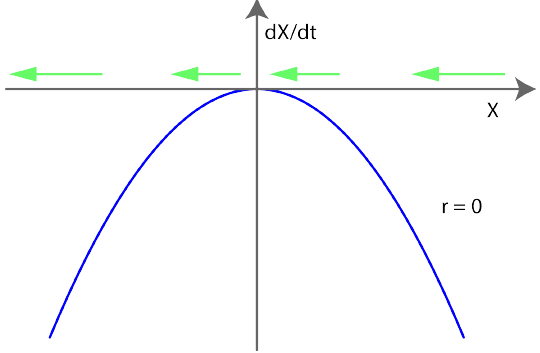
Figure D2. When k 1 = 0, or equivalently r = 0, X converges to 0, but if, for some numerical reason, X is made negative, the kinetic equations will make the concentrations even more negative.